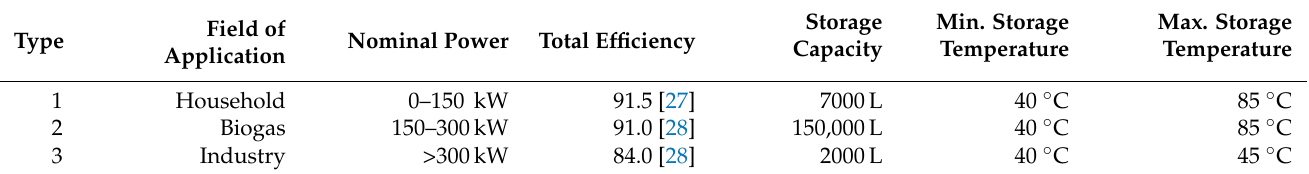
Table 3. Configuration of CHP types to introduce more diverse combined heat and power (CHP) schedules. Each type is integrated into the VPP in equal nominal power